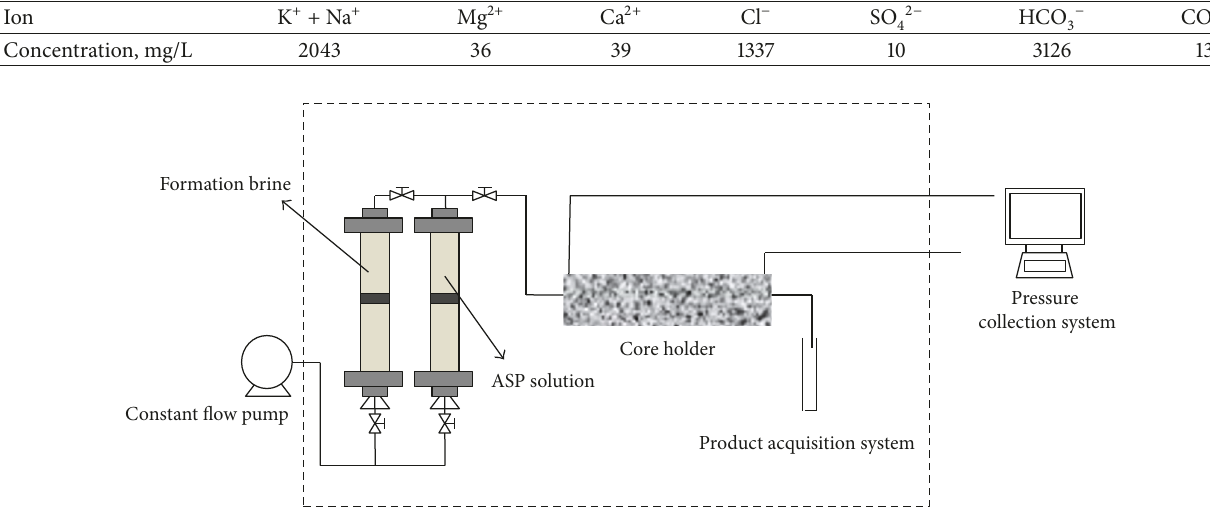
Figure 2: Schematic of the experimental apparatus.